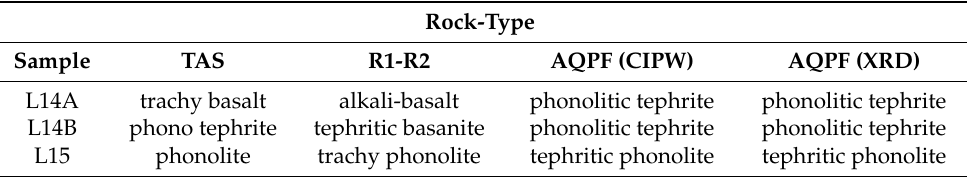
Table 2. Rock-type identification of samples L14A, L14B,